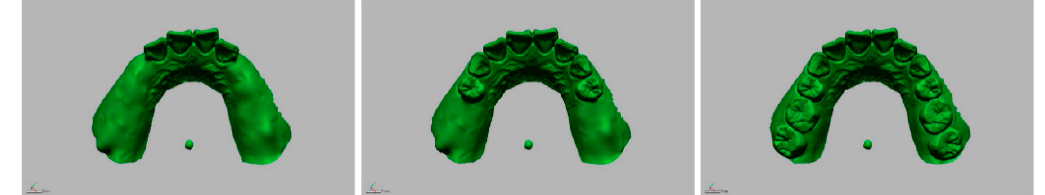
Figure 3. Optical scan images with different numbers of remaining teeth (Left to right: 4, 8, and 12).